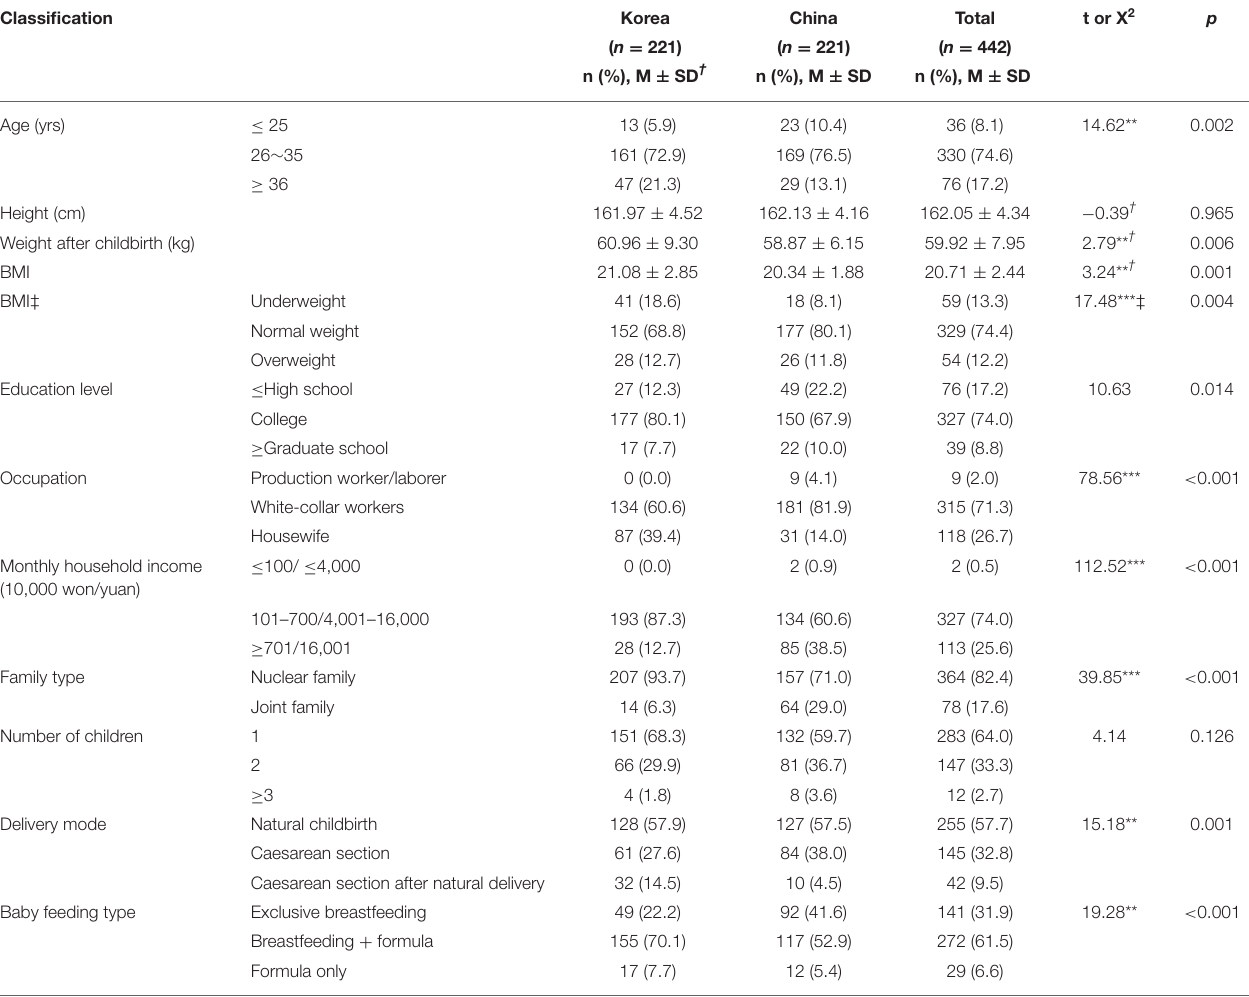
TABLE 1 | Demographic and anthropometric indices of participants by country.